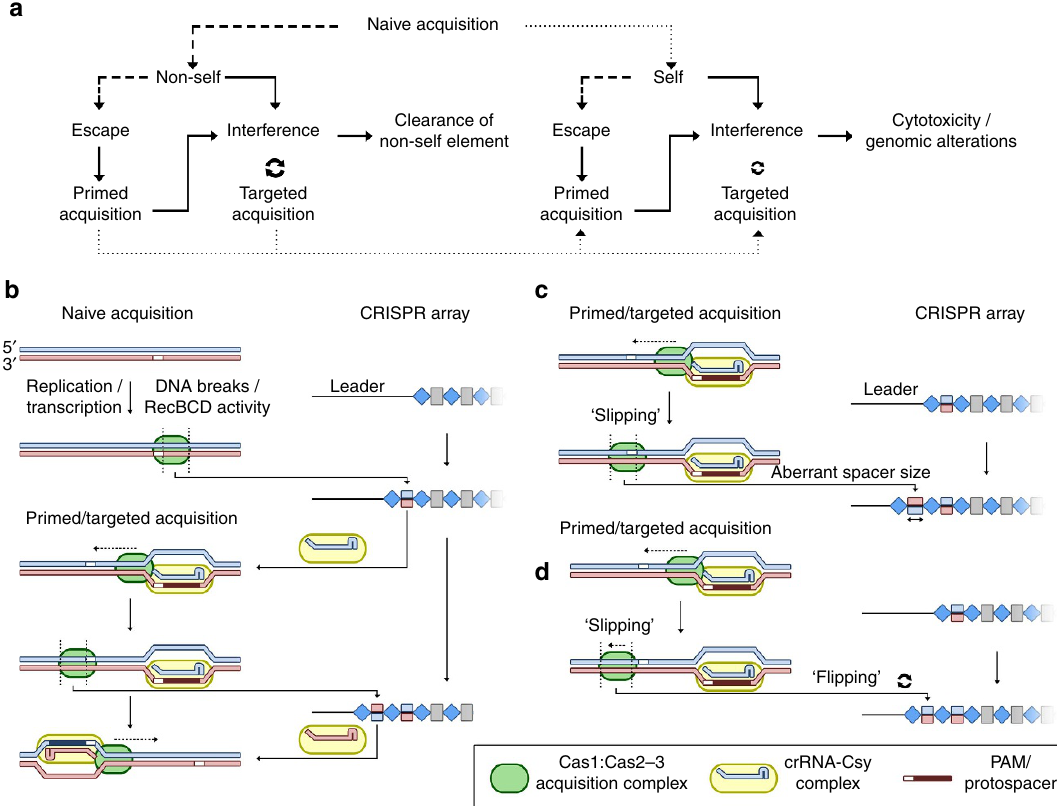
Figure 9 | Model for spacer acquisition in the type I-F system. ( a ) Different routes driving spacer acquisition of self and non-self elements. Rare and very rare events are depicted with dashed and dotted lines respectively. Note that most routes converge on the positive feedback loop between interference and targeted spacer acquisition. ( b ) Model for the recruitment and translocation of the adaptation complex. In this example, acquisition of spacers is initiated by naive acquisition, which is quickly followed up by primed or targeted acquisition. The translocations of the acquisition complex are indicated by dotted black lines. Slipping of the acquisition complex upstream of a PAM can result in ( c ) spacers of aberrant length or ( d ) incorrectly-oriented spacers